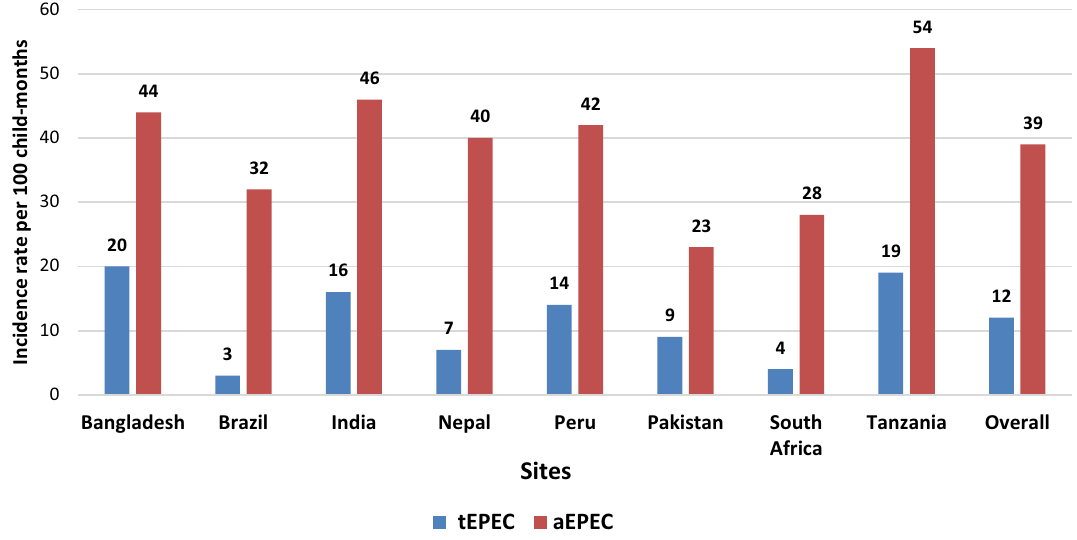
Figure 1. The incidence rate of infection with the two genomic subtypes of EPEC (tEPEC and aEPEC) across each of the eight study sites (Bangladesh, India, Nepal, Pakistan, South Africa, Tanzania, Brazil, and Peru) from November 2009 to February